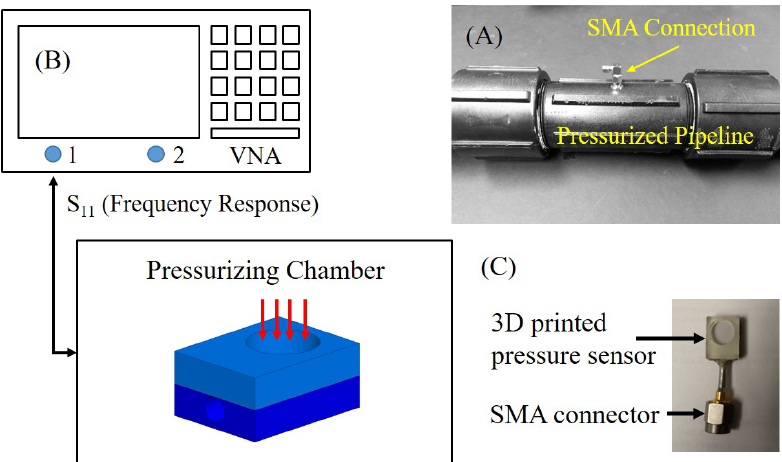
Figure 5. ( A ) Pressurizing chamber (pipe) with integrated pressure sensor, ( B ) Schematic of the measurement setup, and ( C ) Fabricated pressure